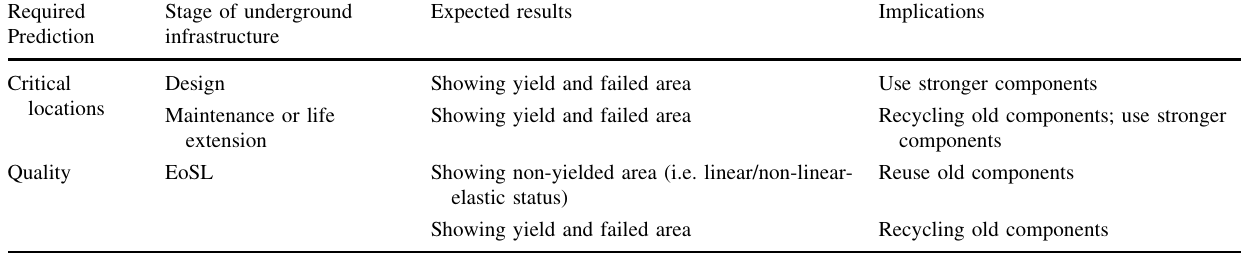
Fig. 2 The brick-lined railway tunnel under uniform load (adapted from [49])